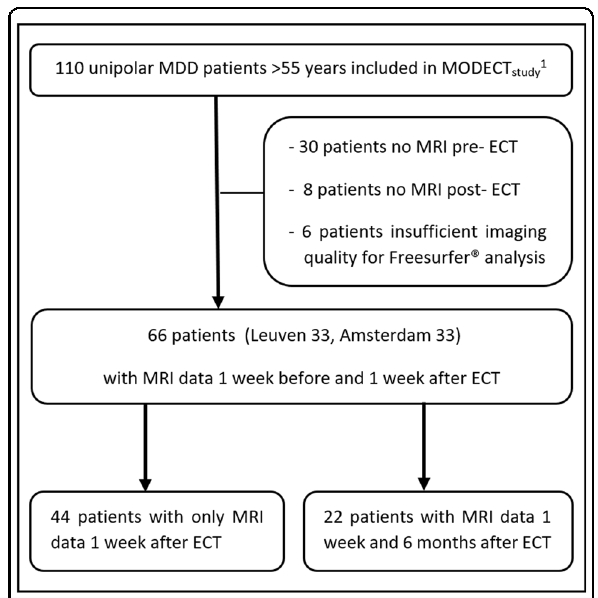
Fig. 1 Flowchart of inclusion/exclusion process. 1 MODECT Mood Disorders in Elderly treated with ECT study (Dols et al. 37 ), MDD major depressive disorder, ECT electroconvulsive therapy, MRI magnetic resonance